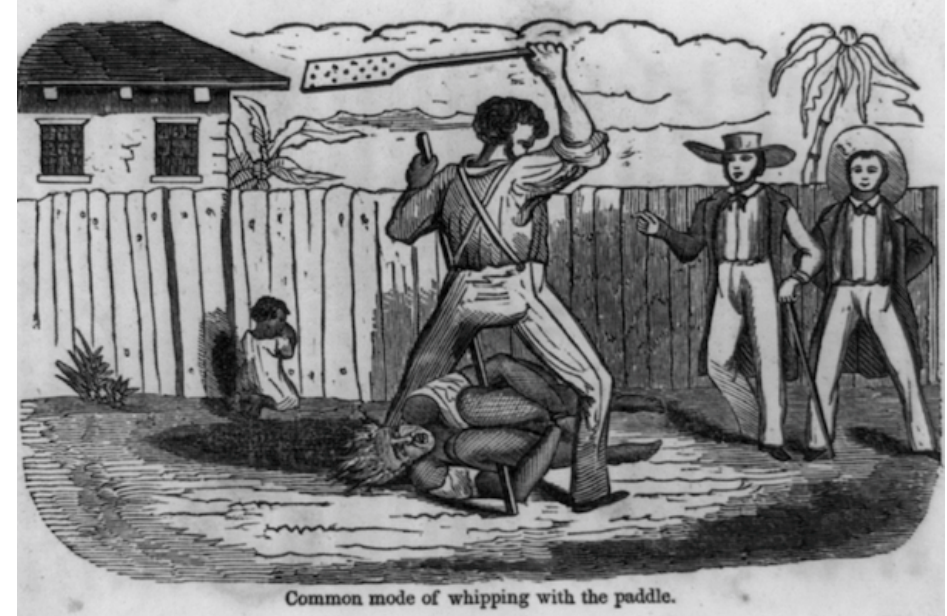
Figure 2. Common mode of whipping with the paddle. “Paddling a Slave, U.S. South, 1845” Slavery Images: A Visual Record of the African Slave Trade and Slave Life in the Early African Diaspora, accessed 31 July 2020, http://slaveryimages.org/s/slaveryimages/item/1255 .